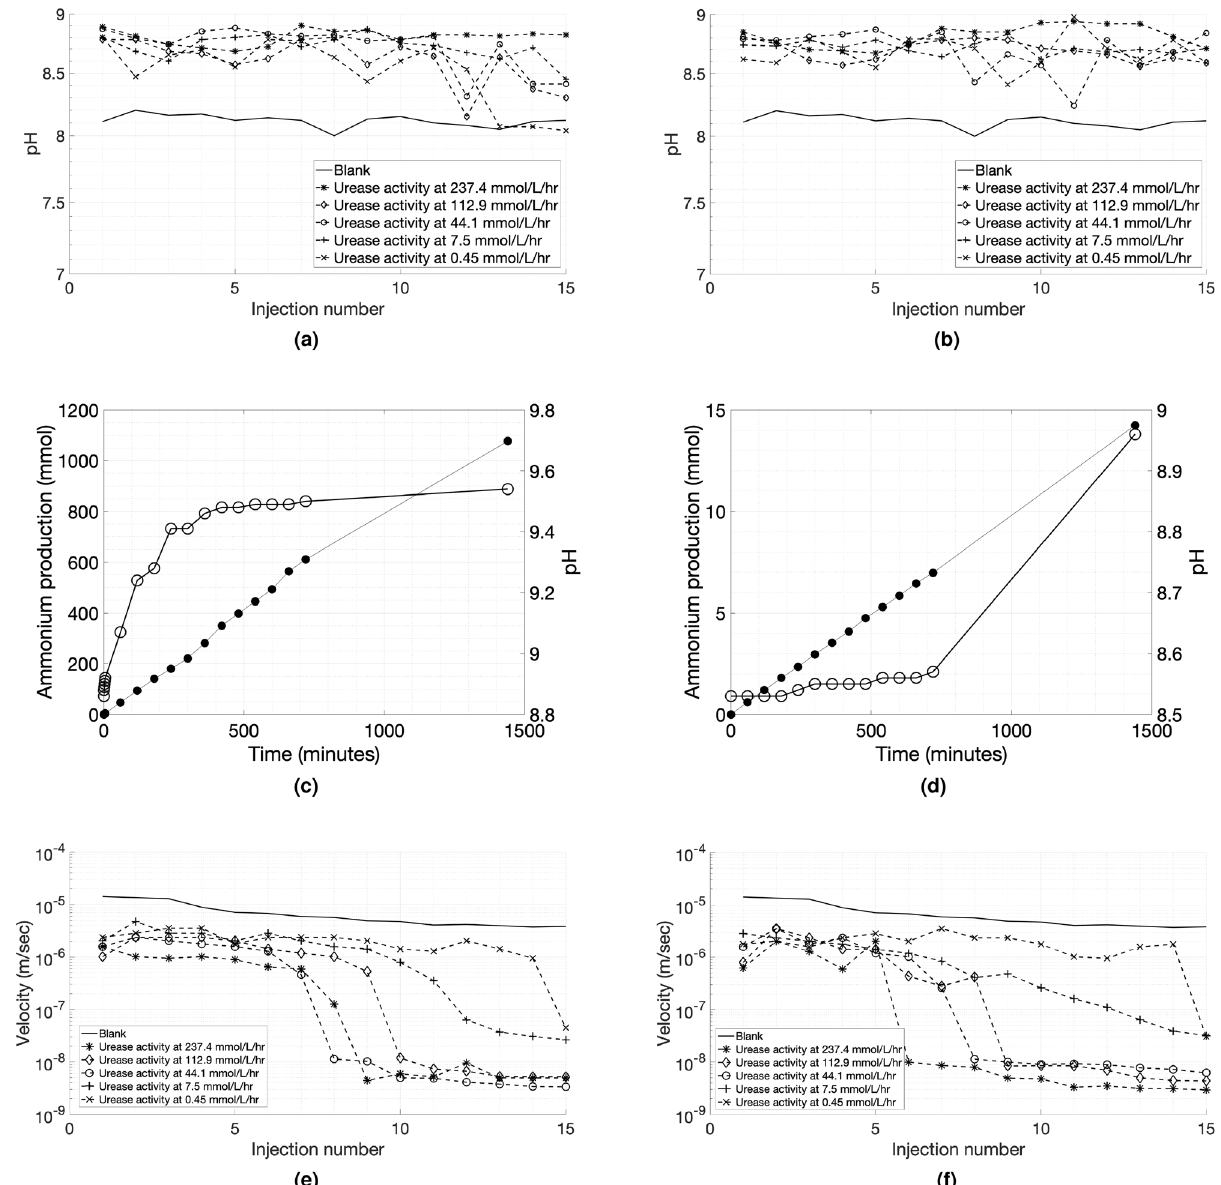
Ammonium production (mmol) measurements ( • ) and pH measurements ( ◦ ) within a time window of 24 h for the bacterial solutions utilised in the sand column experiments: ( c ) 237.4 and, ( d ) 0.45 mmol/L/h measured following the protocol by Whiffin 1 . ( e , f ) Percolation velocities across the injections during the bio-treatment events on a semi-log plot for ( e ) bacteria solutions at a population of OD 600 = 2 and ( f ) bacteria solutions at a population of OD 600 =